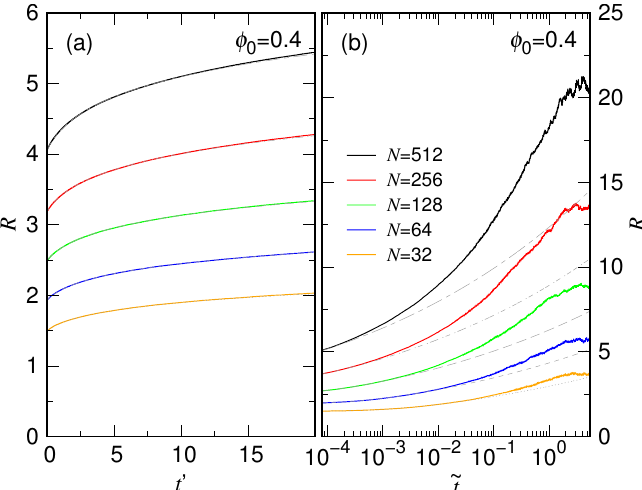
Figure 13. Fitting of the chain size in the first stage of expansion by using the two-parameter fit of Equation (3). The φ 0 is 0.4 and the chain length N is indicated in the legend. The fitting curves are plotted in gray dashed lines. Panel ( a ) is plotted by using the scaled time t (cid:48) = t / τ s in linear scale, for the purpose to check the validity of the fitting. Panel ( b ) is plotted by using ˜ t = t / τ c in logarithmic scale, to have a global view of the fitting curves in the expansion process.